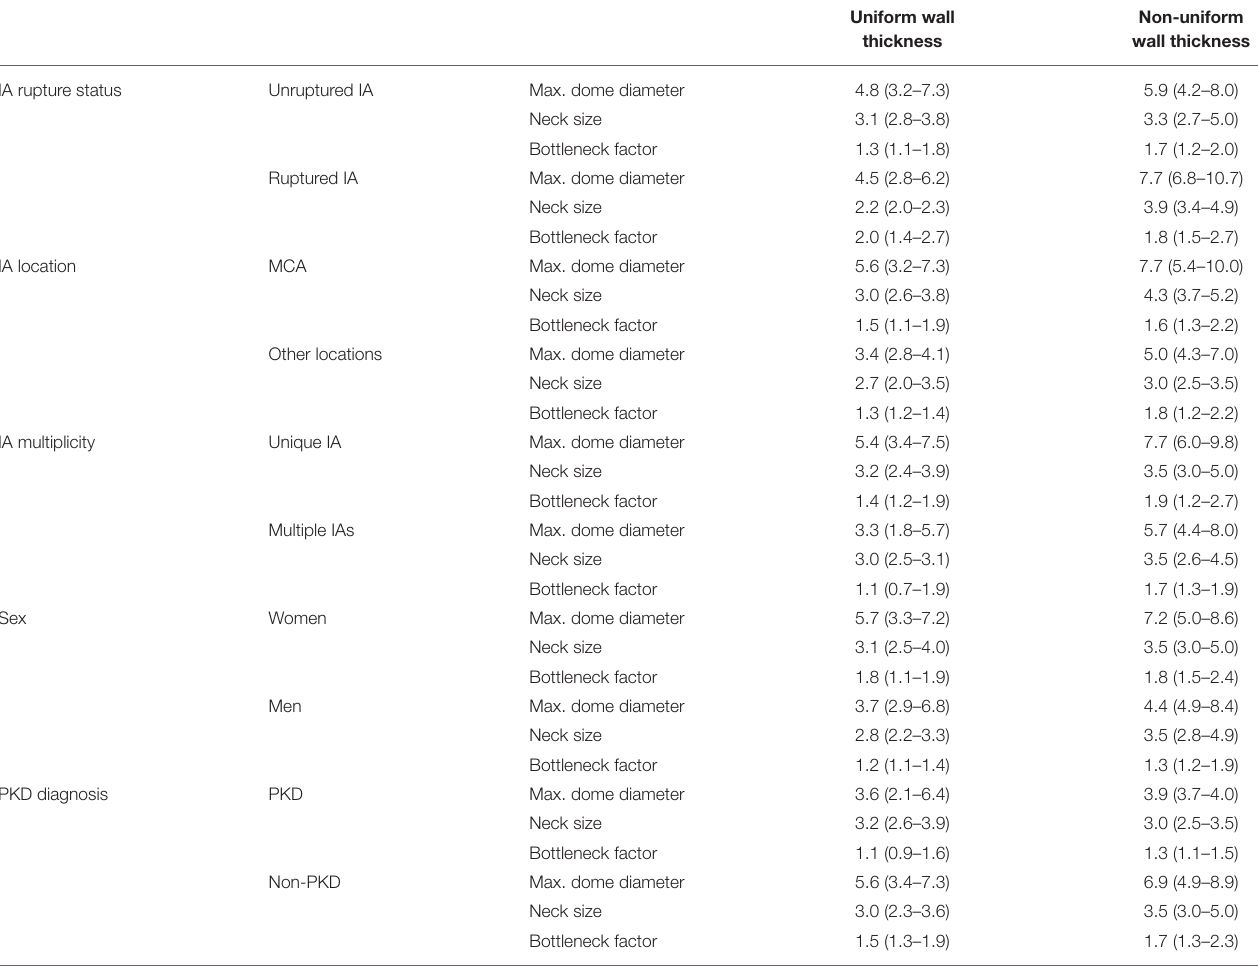
TABLE 1 | Maximum (Max.) dome diameter, neck size and bottleneck factor according to IA rupture status, IA location, IA multiplicity, patient sex, and PKD diagnosis in groups with uniform or non-uniform wall